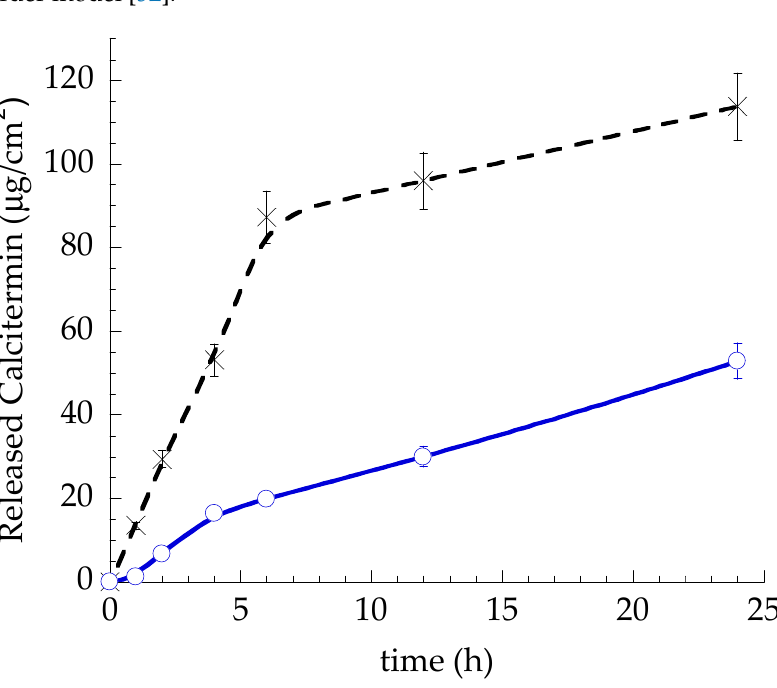
Figure 5. In vitro release kinetics of Cal from Sol Cal (x) and G18/0.4 Cal (o). Data corresponds to the mean values of six experiments ± s.d.